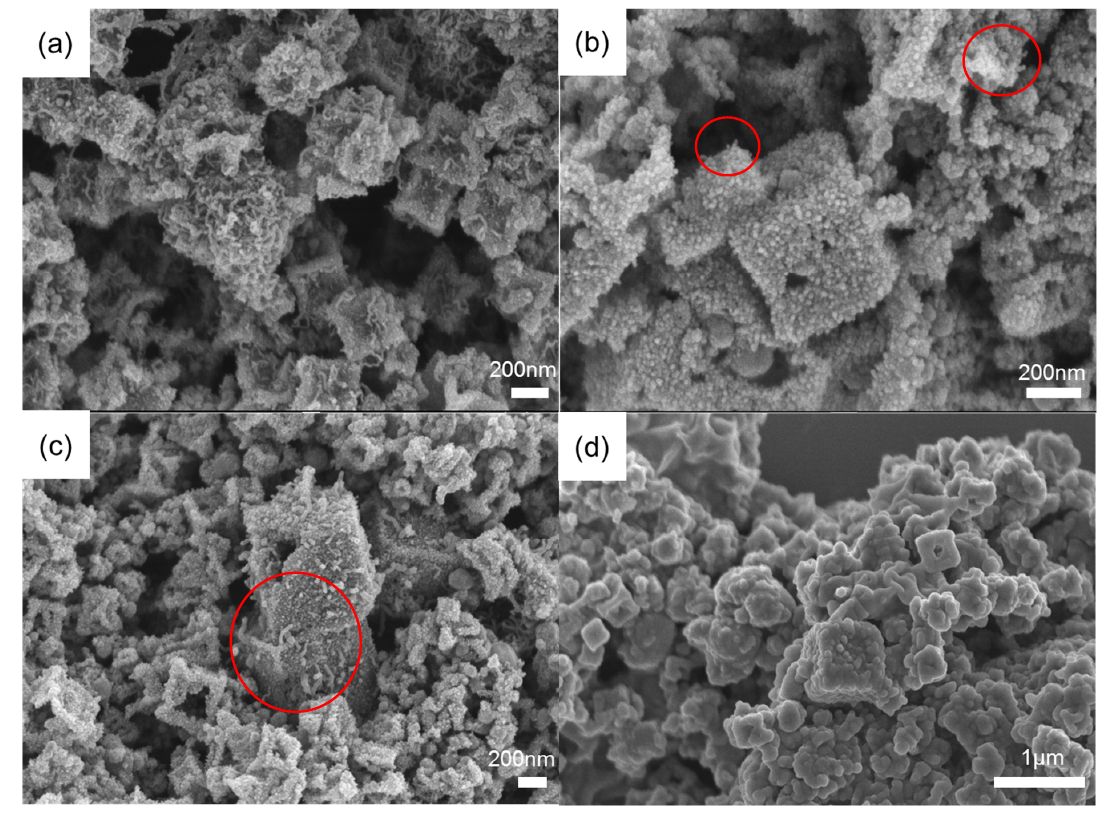
Figure 3. SEM of Ni-doped ZIF-67 after 800 °C pyrolysis: ( a ) S-0, ( b ) S-16, ( c ) S-32, ( d ) S-64.